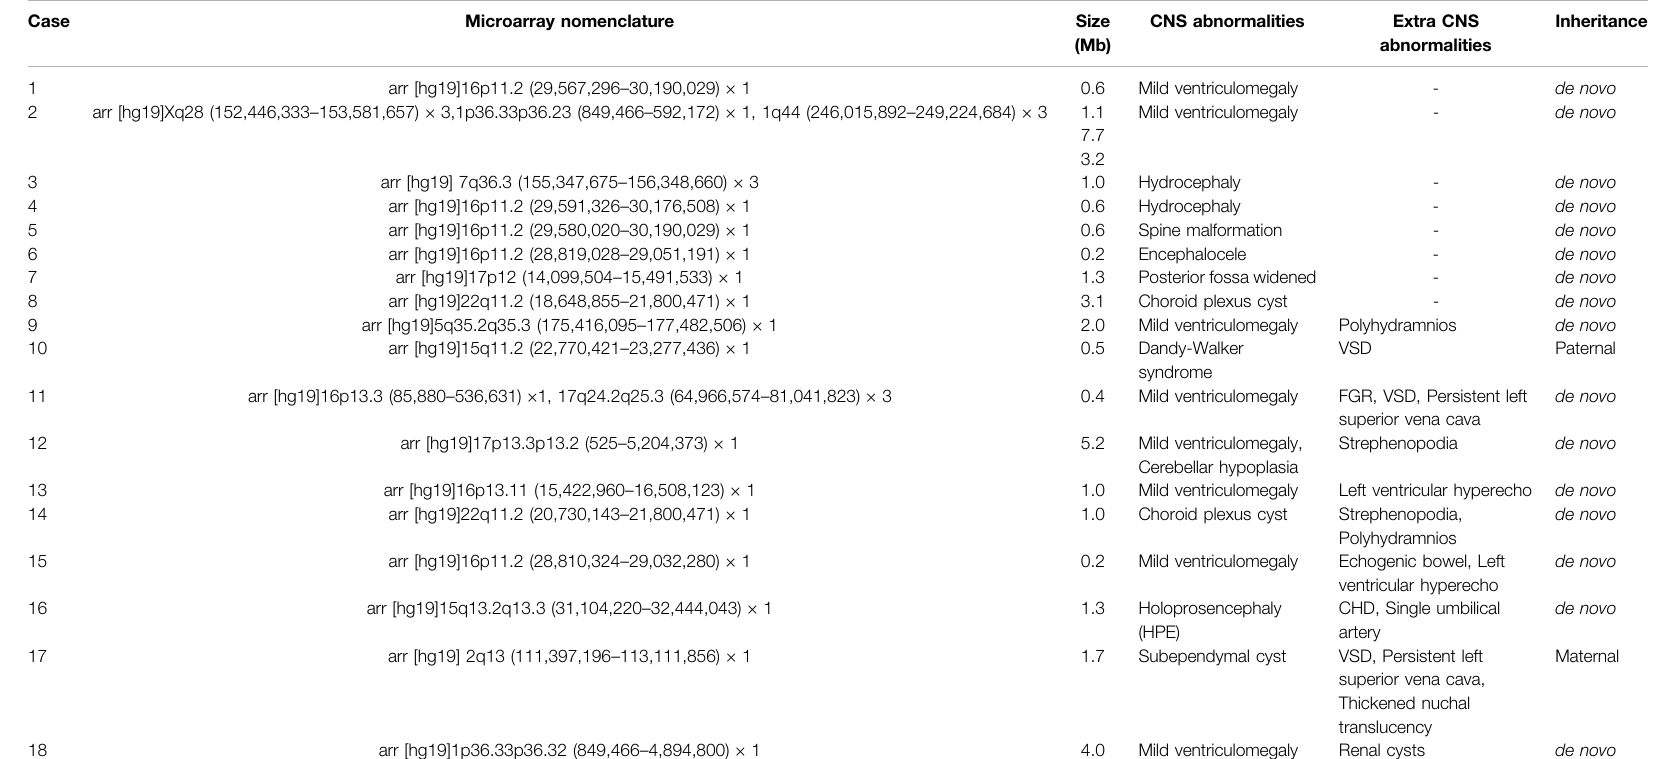
TABLE 3 | The pathogenic CNVs in fetal CNS